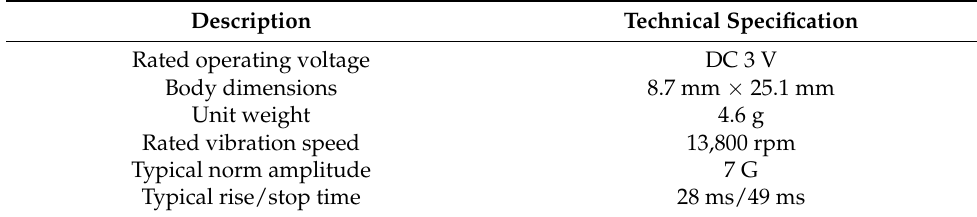
Figure 3. Vibration motors, encapsulated version [18]. Table 1. Specifications Pico Vibe Model 307–103